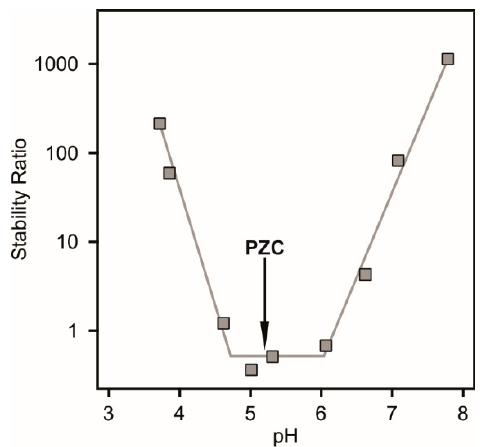
Figure 2. Stability ratio data of spherical titania particles measured at different pH at 7.5 mM ionic strength set by KCl. The particles have a PZC of 5.2 indicated with an arrow. Note that stability ratio values of one indicate that the particle aggregation is controlled solely by the diffusion of the particles, that is, each collision leads to dimer formation. Higher values are signals for slower aggregation rates. The data were taken from Reference [57].